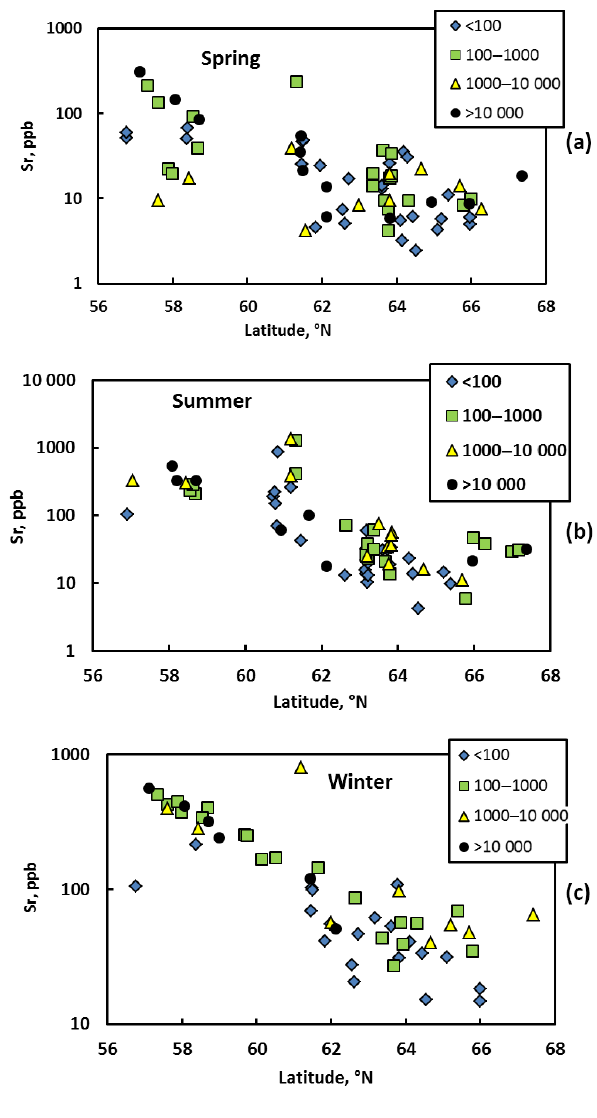
Figure 8. Variation in Sr concentration with latitude during spring (a) , summer (b) and winter (c) for watersheds of different size. The symbols are the same as in Fig. 2. A clear groundwater effect consists in a gradual decrease in concentration northwards, most visible during winter